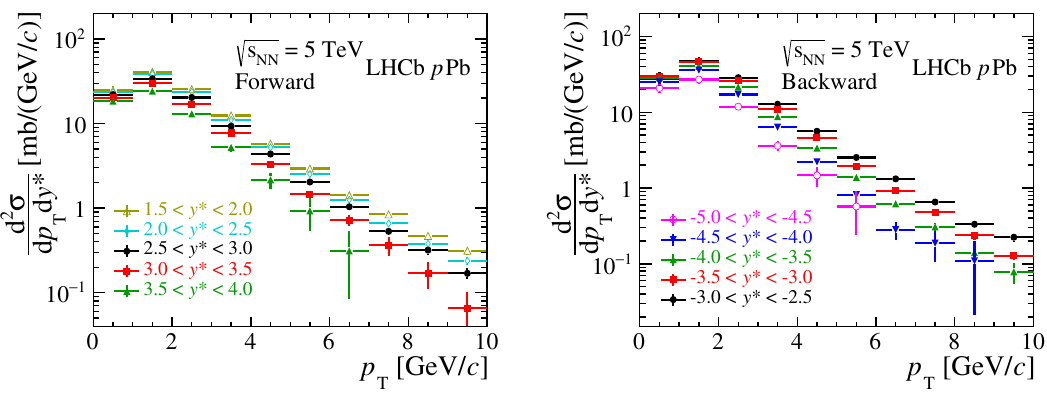
Figure 3 . Double-di(cid:11)erential cross-section d 2 (cid:27) (mb/( GeV =c )) of prompt D 0 meson production d p T d y (cid:3) in p Pb collisions in the (left) forward and (right) backward collision samples. The uncertainty is the quadratic sum of the statistical and systematic